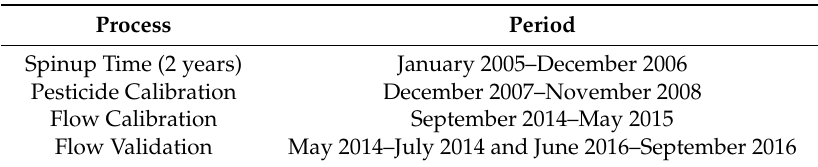
Table 1. Summary of the calibration and validation